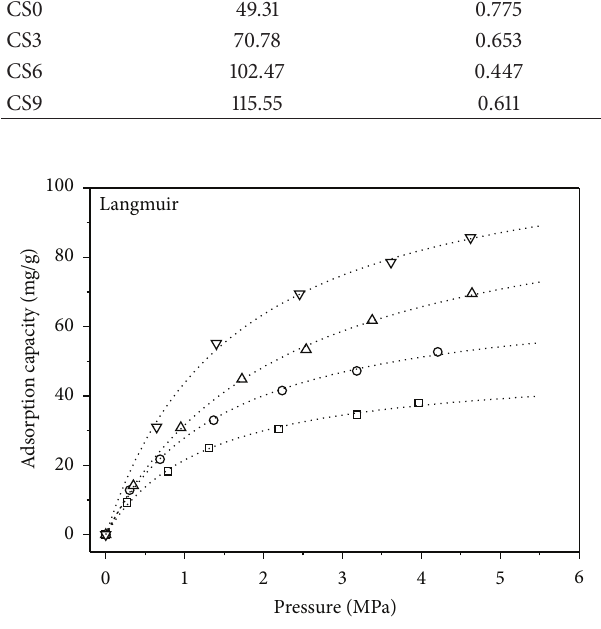
Figure 7: Equilibrium isotherms of methane adsorption on carbon spheres at 298 K. ◻ : CS0; I : CS3; △ : CS6; 󳶚 : CS9; and dotted line: D-A model.